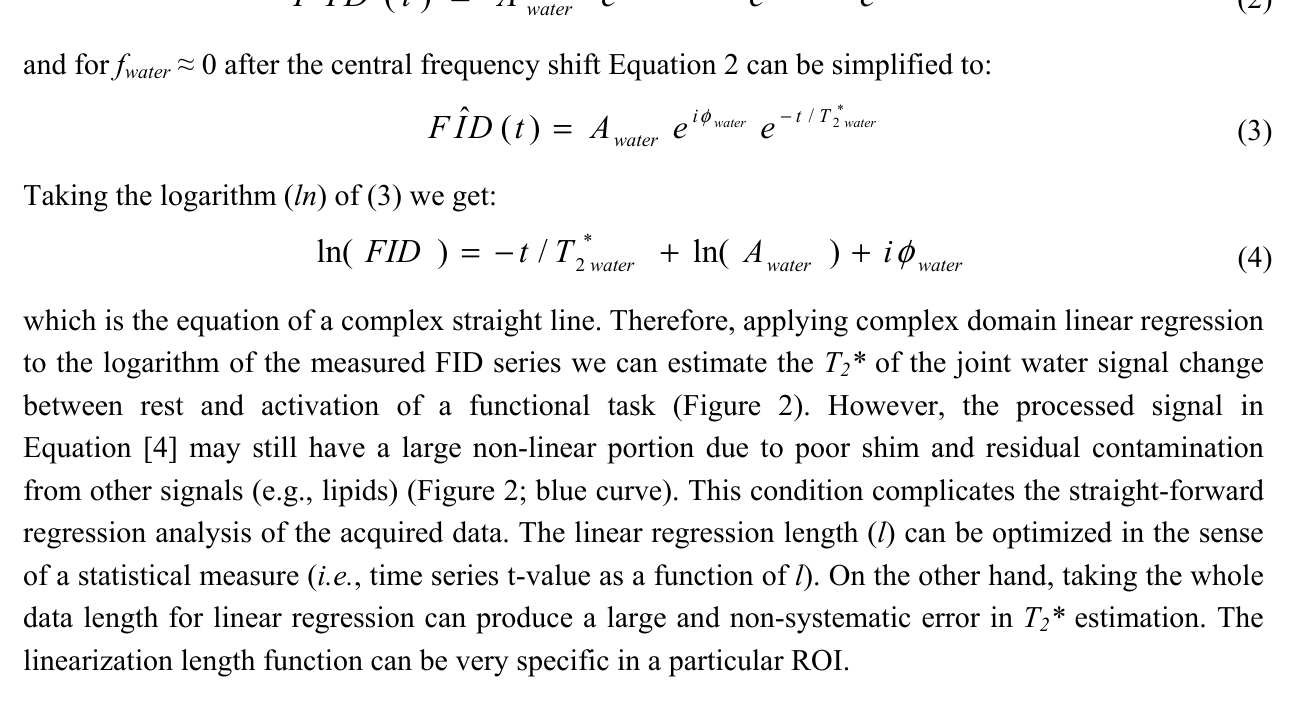
Figure 2. Linear regression of FID data. The linear regression fit (red) is exemplarily shown for a VC fSVPS single voxel ln(FID) data (blue) and its optimal linearization length = 0.078 s, t = 19.12, p < (red dot; l optim